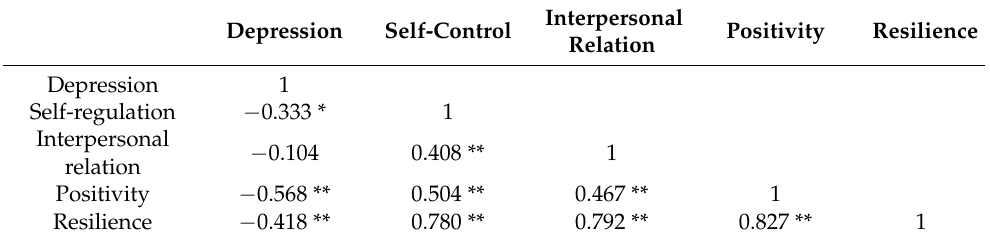
Table 2. Zero-order correlations: meditators. Depression